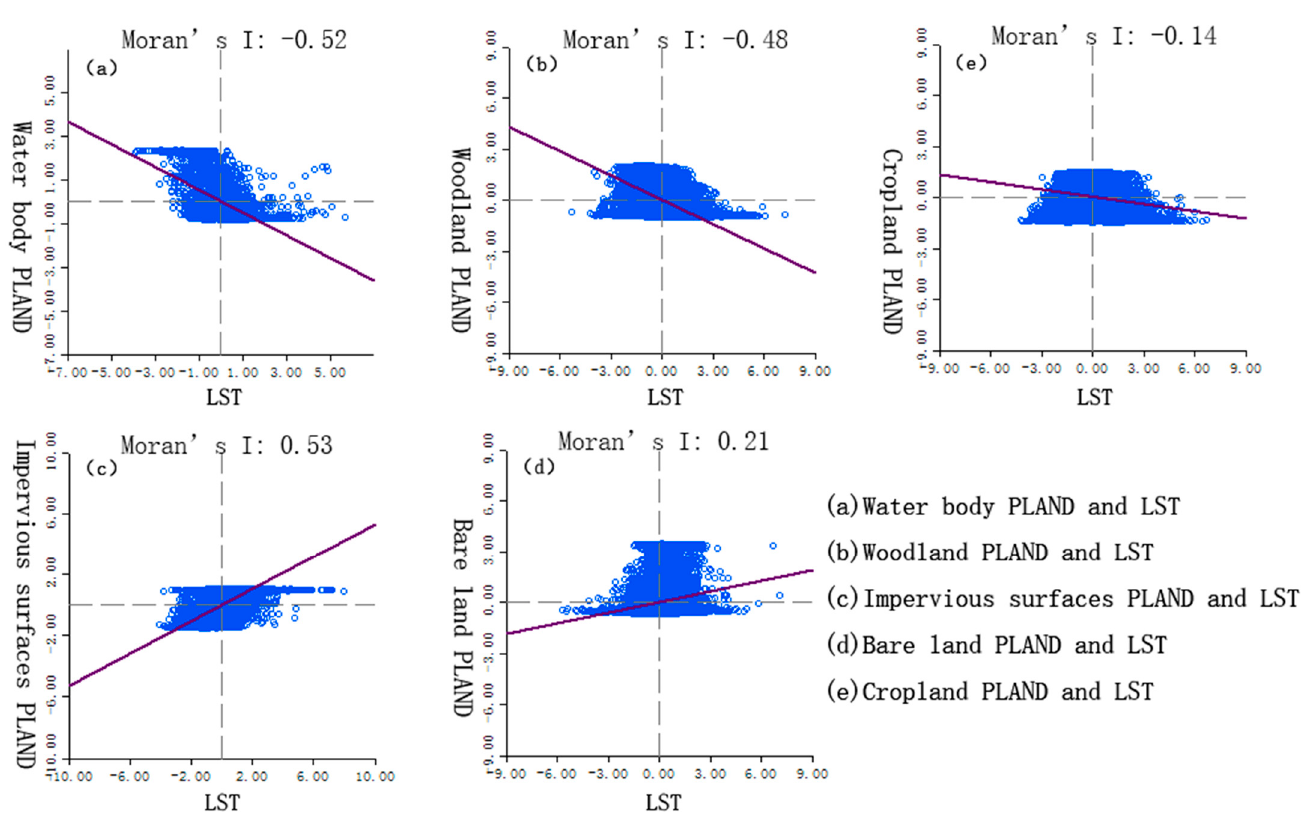
Figure 7. The correlation between five different types of landscape and LST. ( a ) is the correlation between water body PLAND and LST; ( b ) is the correlation between woodland PLAND and LST; ( c ) is the correlation between impervious surfaces PLAND and LST; ( d ) is the correlation between bare land PLAND and LST; ( e ) is the correlation between cropland PLAND and LST.